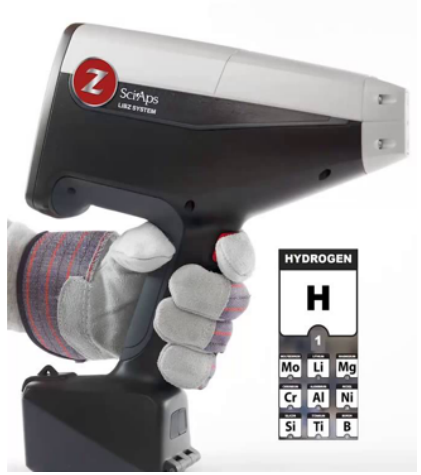
Figure 1. The SciAps Z500-ER hand-held (HH)-LIBS device used in this study.